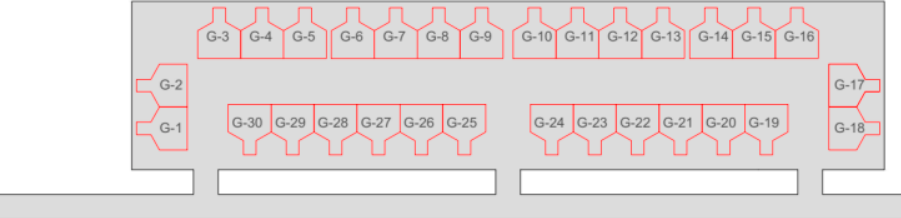
Figure 2. Parking stand assignment diagram.